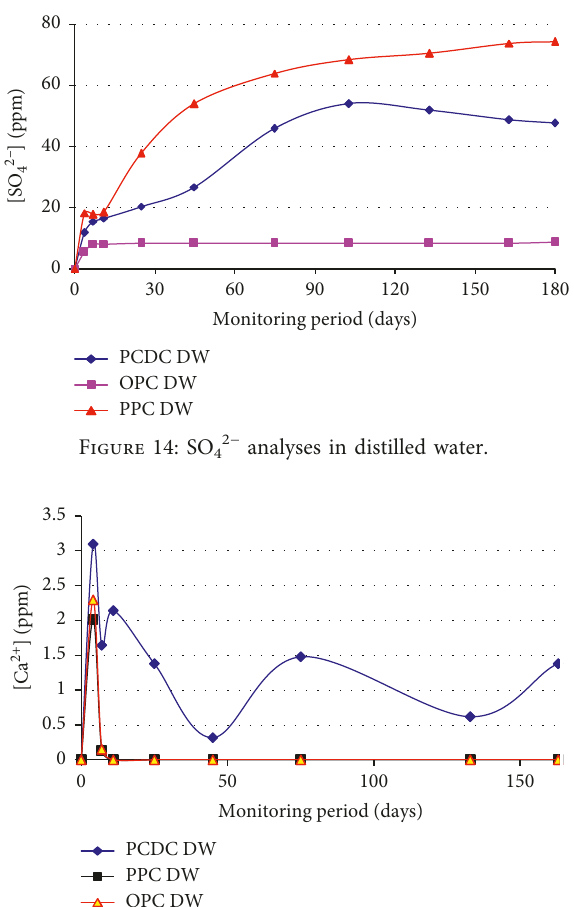
Figure 15: Ca 2+ analyses in simulated distilled water.